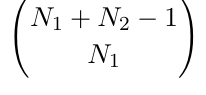
is drawn in the (cid:12)gure 5. If we treat the 5 ; 2 ; 0 + N )! solutions which nicely corresponds to 1 2